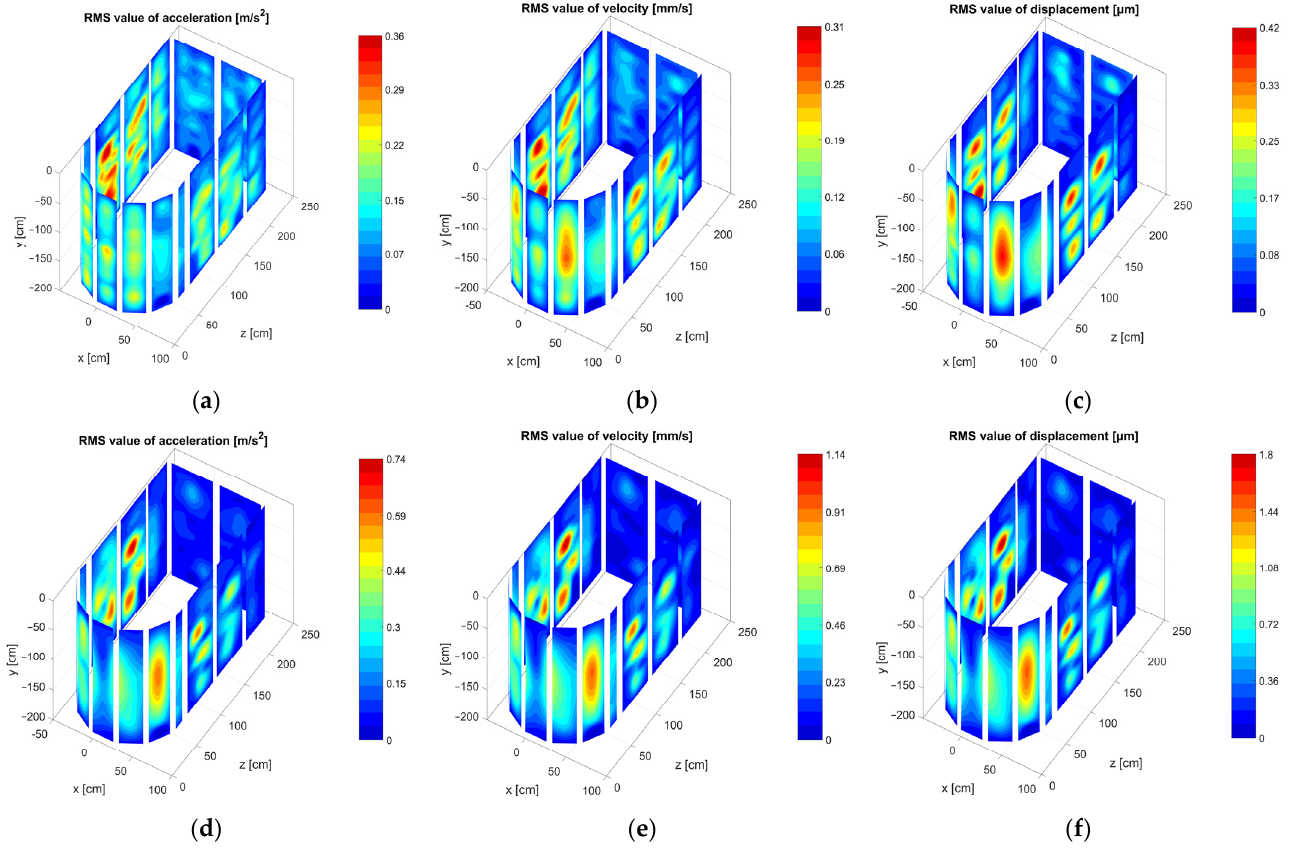
Figure 9. Visualization of RMS values of the vibration acceleration, velocity, and displacement in 3D space in: ( a – c ) open-circuit test, and ( d – f ) short-circuit test. Figure 10 shows visualized RMS values of the vibration velocity of tank wall on frequency components of 100 Hz, 200 Hz, 300 Hz, and 400 Hz in open-circuit and short- circuit tests. In short-circuit test, the frequency component of 100 Hz is dominant. In open- circuit test, the first few 100 Hz harmonics are significant (100 Hz, 200 Hz, and 300 Hz). In open-circuit test highest values of vibration velocity are at surface 12 (100 Hz: 0.25 mm/s; 200 Hz: 0.23 mm/s; 300 Hz: 0.09 mm/s; 400 Hz: 0.04 mm/s), and in short-circuit test highest values are at surface 11 (100 Hz: 1.12 mm/s; 200 Hz: 0.20 mm/s; 300 Hz: 0.05 mm/s; 400 Hz: 0.01 mm/s). Similarities in the excited mode shapes on shown frequency components between two transformer tests can be observed. The most noticeable difference is that vi- bration velocity on the high voltage side of the transformer (surfaces 1–8) is relatively smaller in the short circuit test.